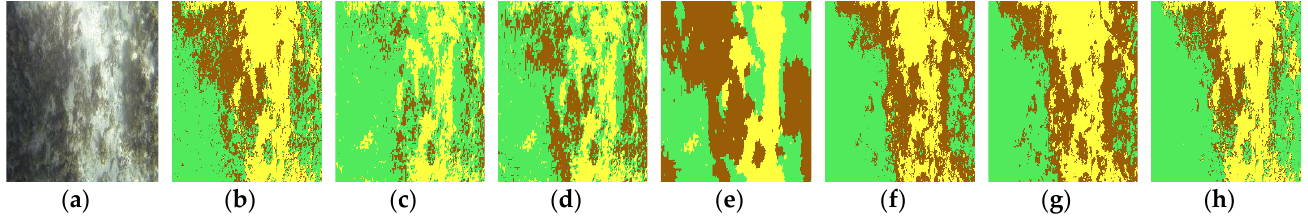
Figure 13. Validation tests of the proposed segmentation algorithms using low illuminated and high contrast brown algae image (1) from Figure 10 as example of two categories: ( a ) original image; ( b ) ground truth image; ( c ) KM result; ( d ) KMAc result; ( e ) FFCr result; ( f ) FRCr result; ( g ) OSCr result; ( h ) KMCr result. 3 – 6. Brown: brown algae and yellow: sediments.